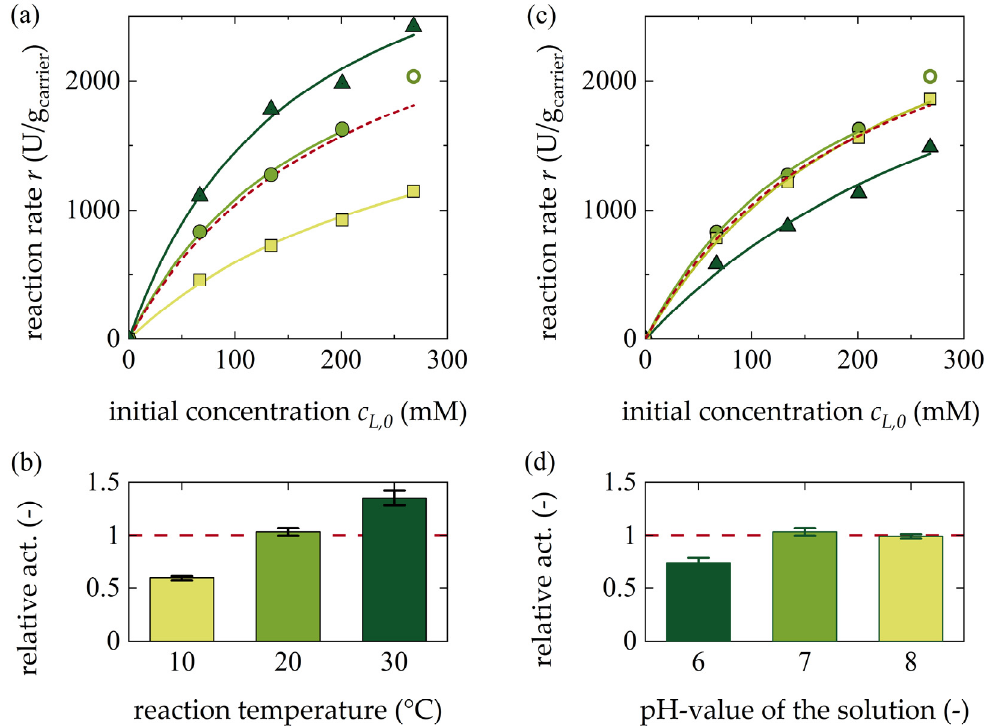
Figure 3. ( a ) Reaction rates at three reaction temperatures (10 ◦ C: light green; 20 ◦ C: medium green; 30 ◦ C: dark green) for L -Met at pH 7 (reference in pure water without buffer at 20 ◦ C: –). ( b ) Average activity in dependence of reaction temperature normalized to the reaction rate without buffer at 20 ◦ C (–). ( c ) Reaction rates for different pH values of the solution (pH 6: dark green; pH 7: medium green; pH 8: light green) for L-Met (reference without buffer at 20 ◦ C: –). ( d ) Average activity in dependence of the pH value normalized to the reaction rate without buffer at 20 ◦ C (–). It should be mentioned that, in contrast to operation at 10 ◦ C and 20 ◦ C, an